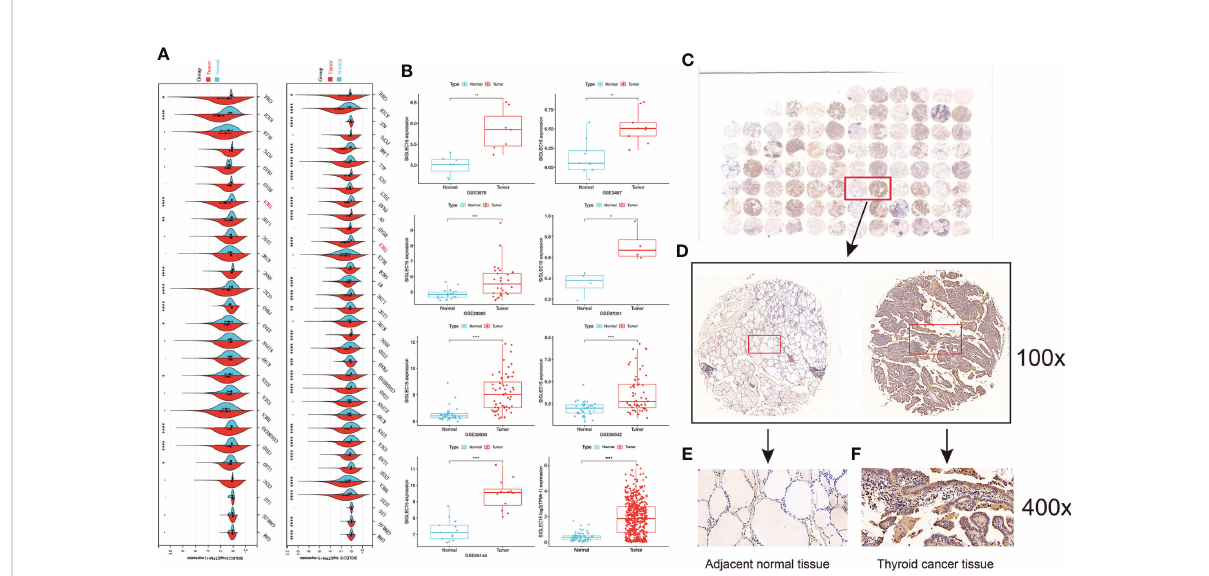
FIGURE 2 Analysis of the expression of SIGLEC15 . (A) Pan-cancer mRNA expression of SIGLEC15 between tumor and normal tissues from The Cancer Genome Atlas, and GEO is Gene Expression Omnibus and Genotype-Tissue Expression database. (B) mRNA expression of SIGLEC15 between tumor and normal tissues from GEO and The Cancer Genome Atlas, and GEO is Gene Expression Omnibus database. (C) A classic pair of samples. (D – F) Left sample was adjacent normal tissue. Right sample was thyroid carcinoma tissue. Thyroid carcinoma tissue has higher